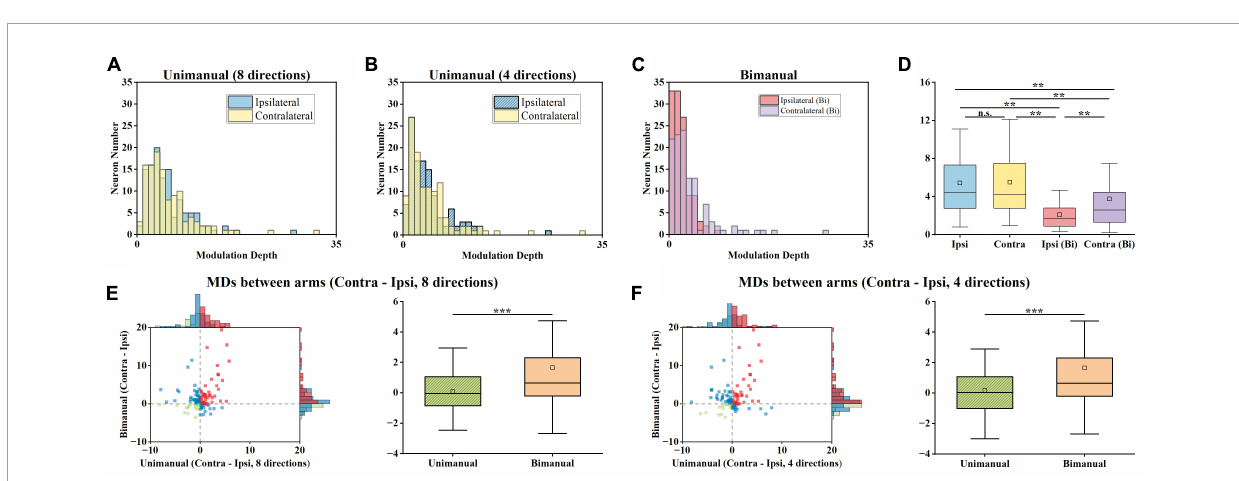
FIGURE7 Both the ipsilateral and contralateral modulation depths (MDs) were significantly suppressed across unimanual and bimanual tasks, especially the ipsilateral side. (A) Distribution of MDs for ipsilateral and contralateral arms during unimanual movements, for unimanual-8-direction data. (B) Same as in panel (A) , but for the 4-direction data. (C) Same as in panels (A,B) , but for bimanual movements. (D) Boxplots of MDs across neurons. (E) Comparison of MDs between arms during the unimanual versus bimanual movements for unimanual-8-direction and bimanual data. (F) Similar to panel (E) , but for unimanual-4-direction and bimanual data. The significant suppression of the MDs of both arms was observed during the bimanual versus unimanual task. While the distributions of MDs for both arms were similar during the unimanual task, the shifts in MDs during the bimanual task led to the larger MDs in the contralateral versus ipsilateral sides in the bimanual task. ** p < 0.01, *** p < 0.001, t -test.